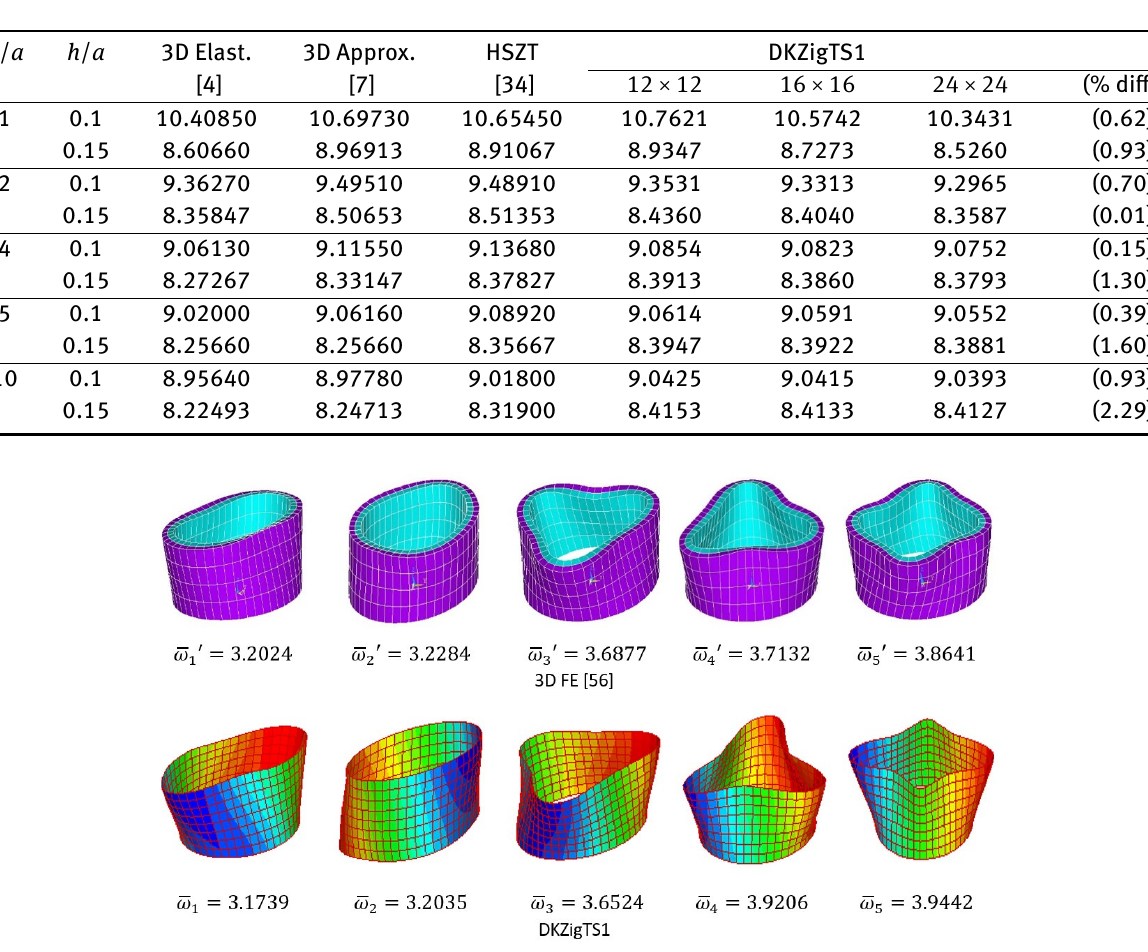
Figure 8: Comparison of first five mode shapes for cantilever composite cylinder of shell ‘B’, L / R = 1 and h / R =